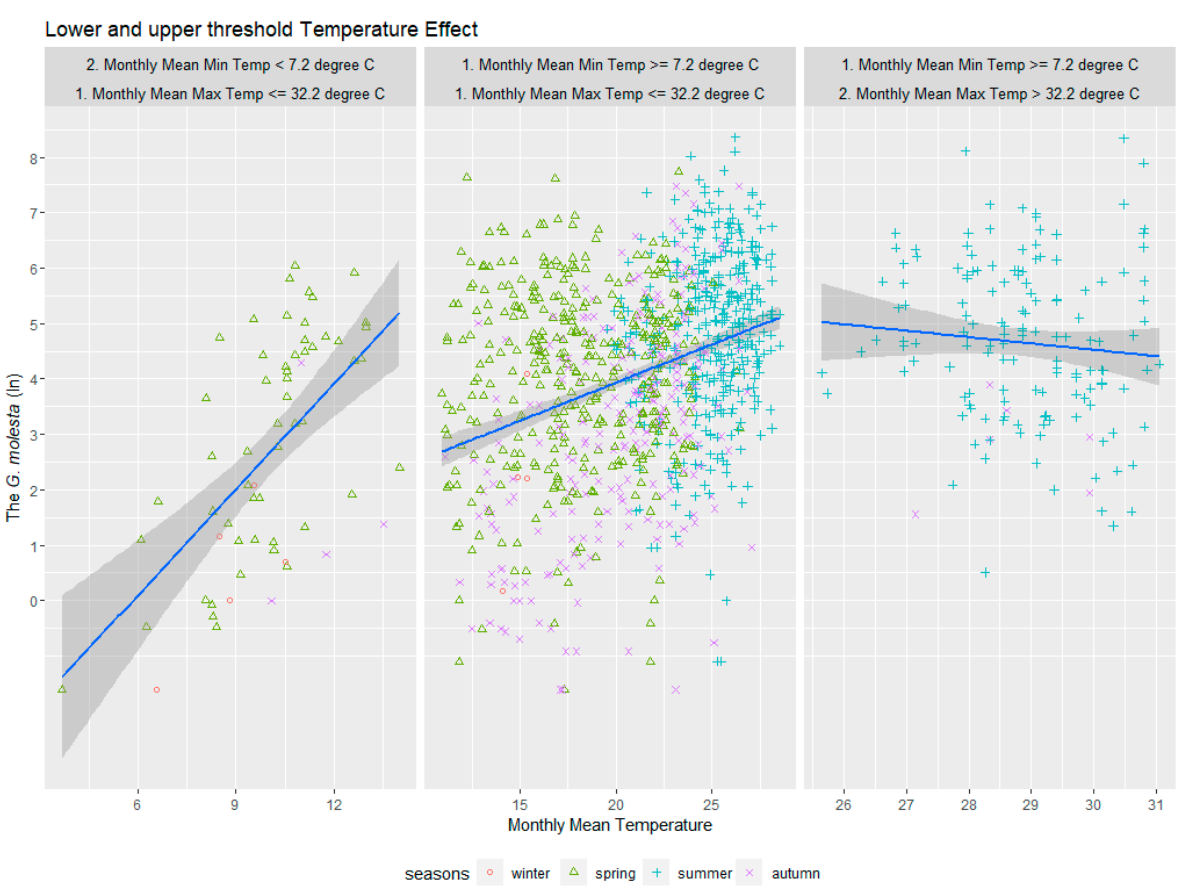
Figure 4. The lower and upper threshold effects on the relationship between temperature and G. molesta population from all sites of the 17 experimental stations.